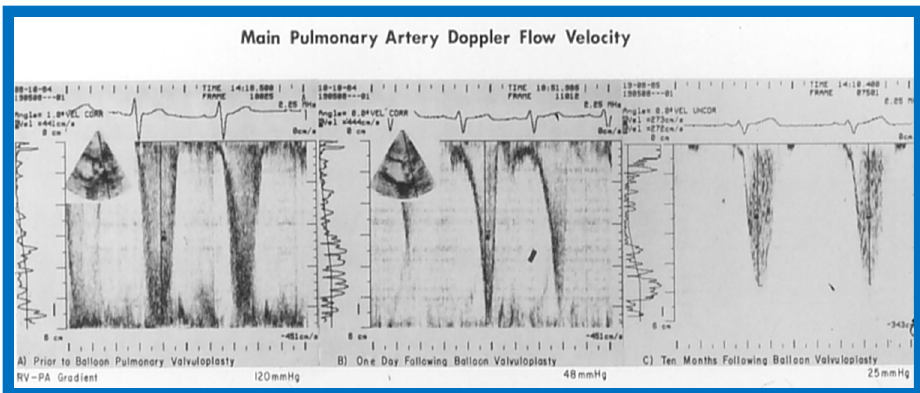
Figure 49. Doppler flow velocity recordings from the main pulmonary artery prior to ( A ), immediately after ( B ) balloon pulmonary valvuloplasty and at 10-month follow-up ( C ). Note the high Doppler flow velocity prior to balloon pulmonary valvuloplasty indicating severe gradient in A; the Doppler velocity immediately after balloon pulmonary valvuloplasty has a triangular pattern, indicating the infundibular gradient in B and corresponding to A in Figure 50. At follow-up 10 months later, the Doppler velocity had fallen ( C ) and corresponded to B in Figure 50, suggesting resolution of infundibular obstruction. Reproduced from Rao P.S. [14].